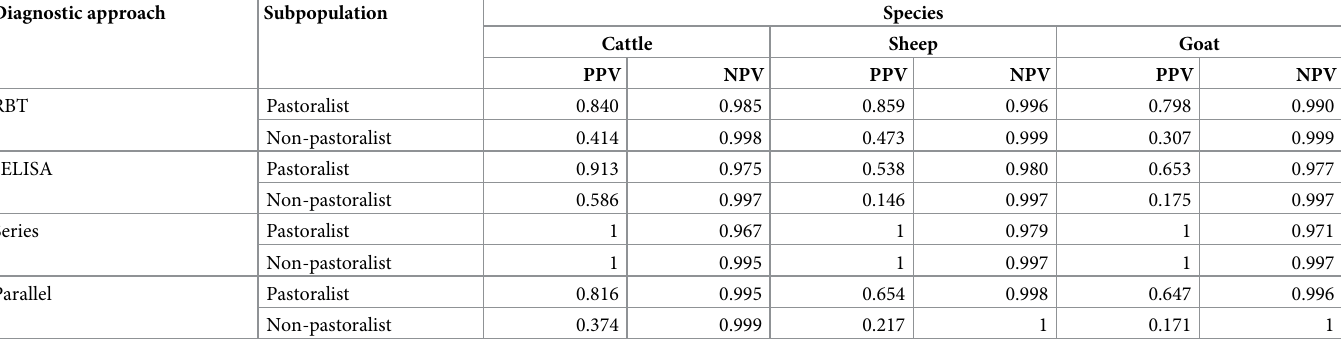
Table 5. Positive and negative predictive values for RBT only, cELISA only, series, and parallel diagnostic testing approaches for two subpopulations using cattle, sheep, and goat model estimates. Diagnostic